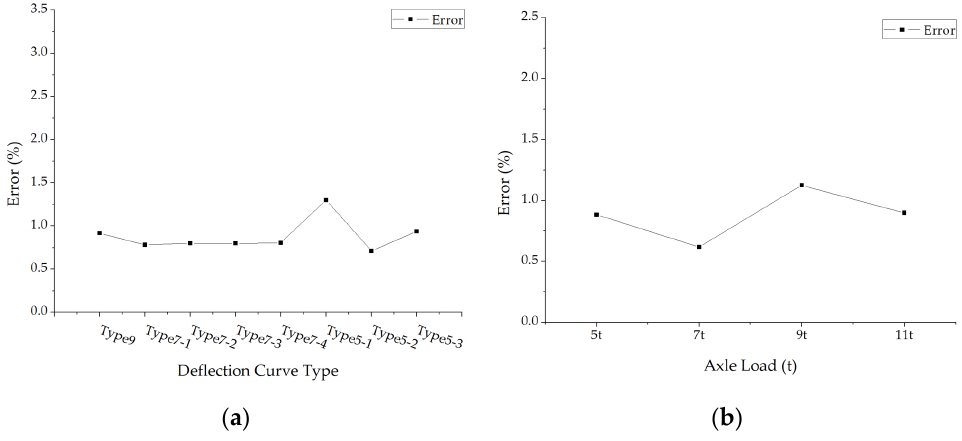
Figure 12. The average errors of back calculated subgrade modulus: ( a ) The average errors under different deflection curve types; ( b ) The average errors under different axle loads.